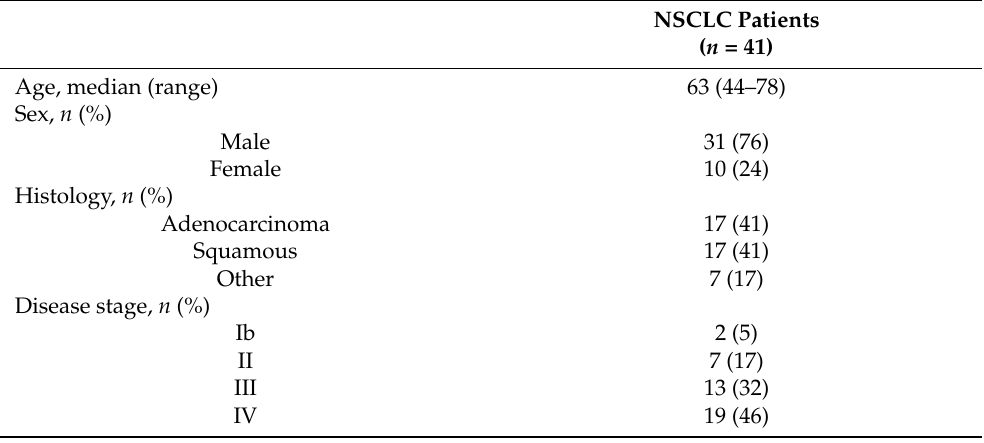
Table 1. Clinical and demographic characteristics of patients with non-small cell lung cancer